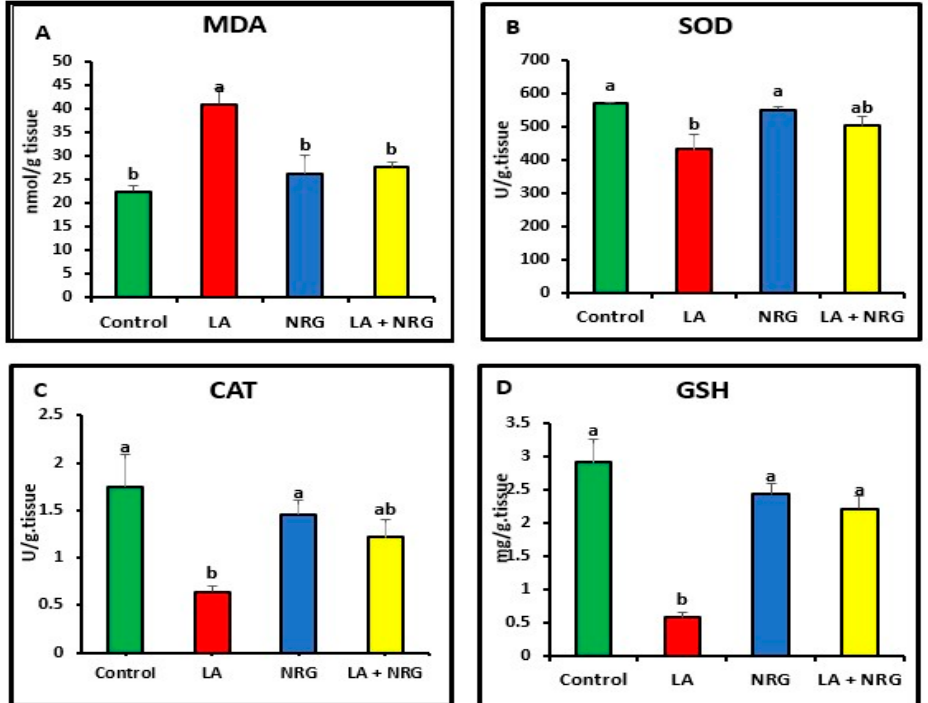
Figure 4. Hepatic oxidative/antioxidative parameters: ( A ) MDA (nmol/g tissue), ( B ) SOD (U/g tis- sue), ( C ) catalase (U/g tissue), and ( D ) GSH (mg/g tissue) at the 4th week of treatment of LA-intox- icated rats with NRG (mean ± SE)). The means in each chart with di ff erent superscripts are signi fi - cantly di ff erent ( p < 0.05). MDA: malondialdehyde; SOD: superoxide dismutase; CAT: catalase; GSH: reduced glutathione. a for the high value; while b for the lower value.